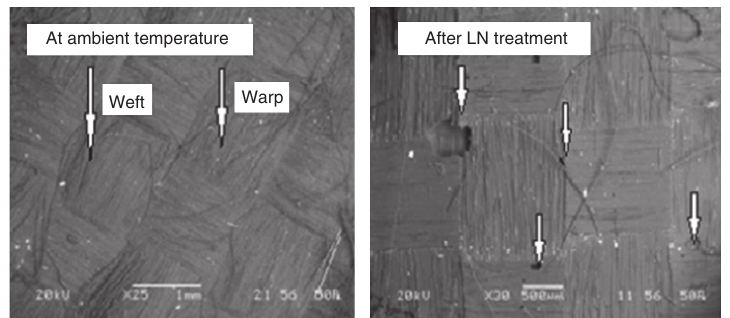
samples shows the matrix swelling and matrix 2